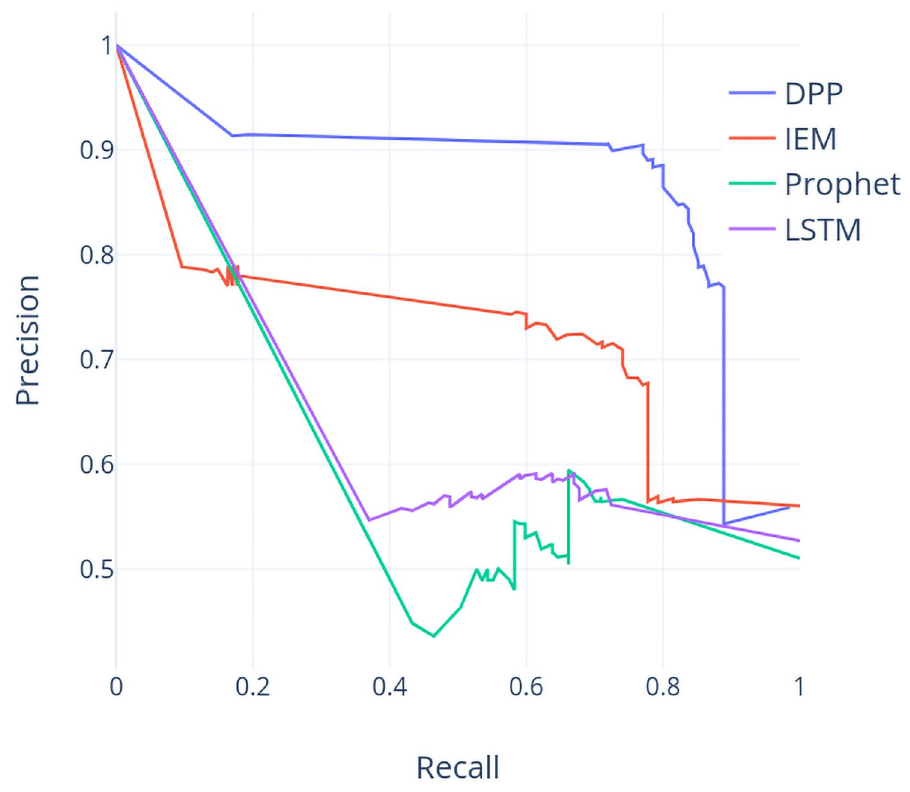
Fig 10. PR curve (TX